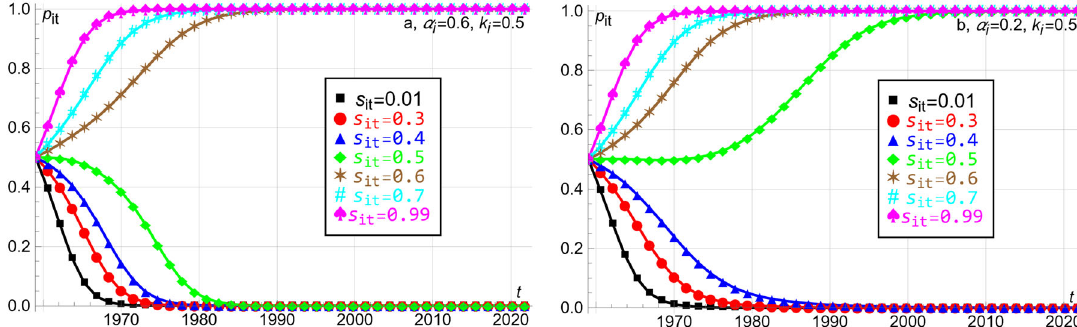
Fig. 4 The volume fraction p it of player i ’ s transactions in currency g at time t 1959 – 2021 with the utilities u igt and u int in Eqs. (4) and (5) when ¼ k ¼ 0 : 5, μ ¼ 0, and 0 : 01 (cid:4) s q it ¼ p it i i 0